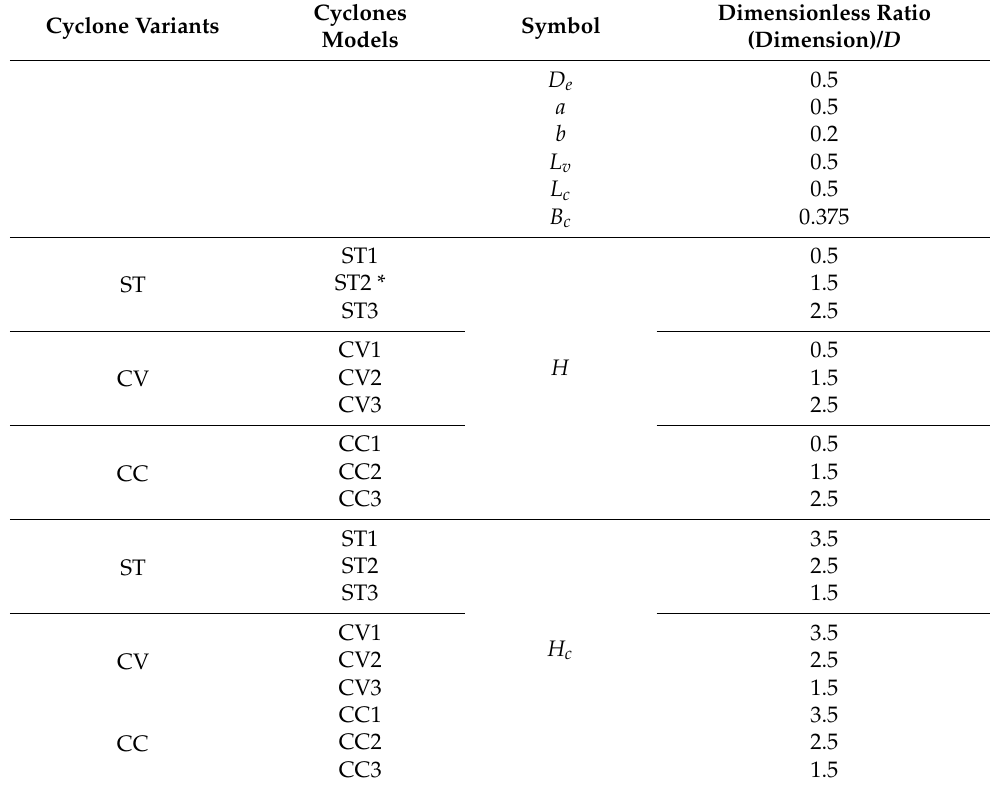
Table 1. Dimensions of the cyclone